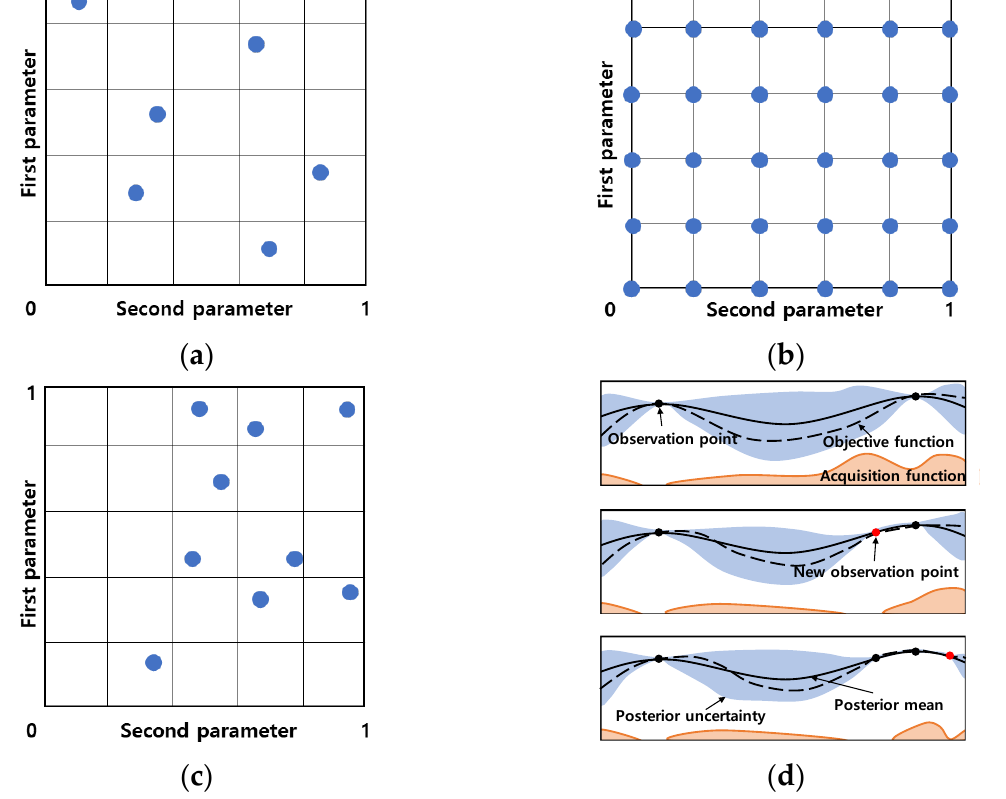
Figure 4. ( a ) Manual search, ( b ) grid search, ( c ) random search, and ( d ) Bayesian optimization [14].